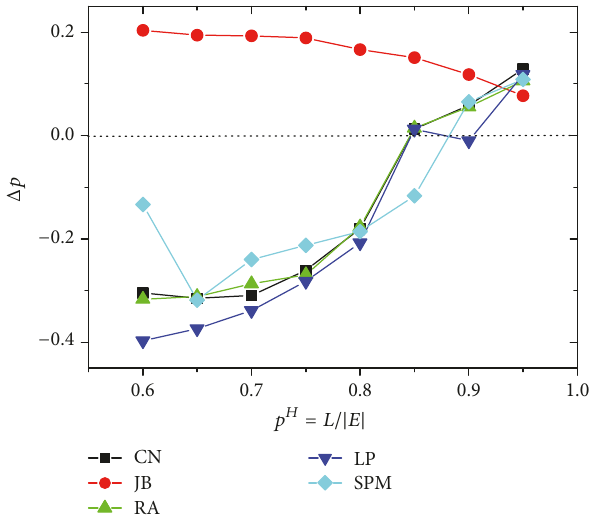
Figure 4: The precision difference Δ𝑝 as a function of probe set size 𝑝 𝐻 = 𝐿/|𝐸| in Usair network. Δ𝑝 = 𝑝 that our method outperforms the original methods. In the panel, when 𝑝 𝐻 > 0.85 , Δ𝑝 > 0